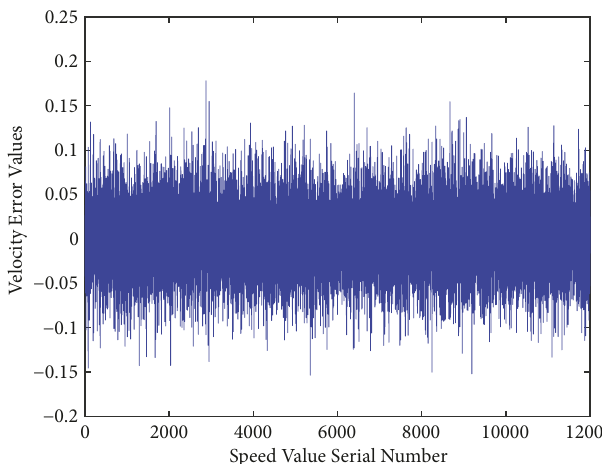
Figure 3: Curve of velocity error